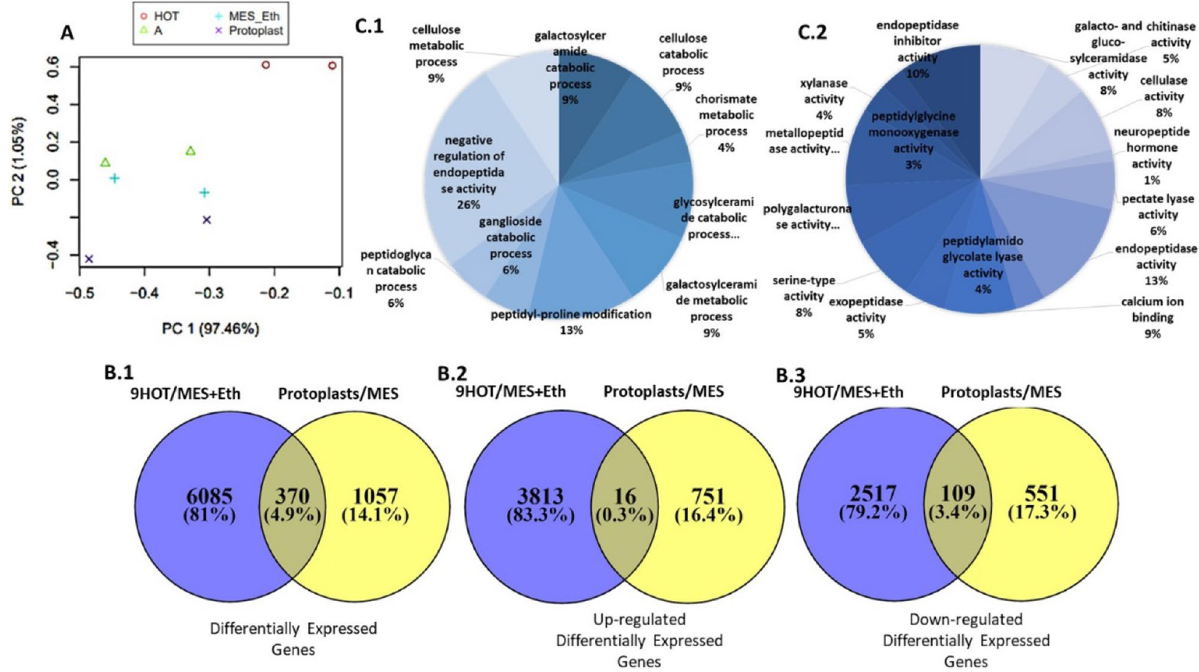
Figure 3. ( A ) Principal components analysis (PCA). Distribution of differentially expressed genes. Three- dimensional representation according to PCA of the differentially expressed genes among the four treatments used in the RNA-Seq analysis: J2 of M. javanica exposed to protoplasts, 9-HOT, or MES + ethanol (MES + Eth), or freshly hatched J2. Samples with similar expression profiles lie closer to each other than those with dissimilar profiles. Axes 1 and 2 show robust class separation into two major groups: (1) 9-HOT, (2) J2 and MES + ethanol and protoplasts. ( B ) Venn diagram showing number of overlapping and non-overlapping differentially expressed M. javanica genes following exposure to: protoplasts/control (Cont.) and 9-HOT/control. ( B.1 ) distribution of all differentially expressed genes. ( B.2 ) Distribution of up-regulated genes found in each treatment as well as genes overlapping between both treatments. ( B.3 ) Distribution of down-regulated genes found in each treatment as well as genes overlapping between both treatments. Fold change with an absolute value > 2 and < − 2 and p value ≤ 0.001 was used for the analyses. ( C ) Gene ontology (GO) annotations of differentially expressed genes of M. javanica J2 exposed to 9-HOT vs. control unigenes at multilevel using BLAST2go software. The GO terms were categorized into ( C.1 ) biological process and ( C.2 ) molecular function. Pie chart slices represent the percentages of genes identified in a particular category among the differentially expressed